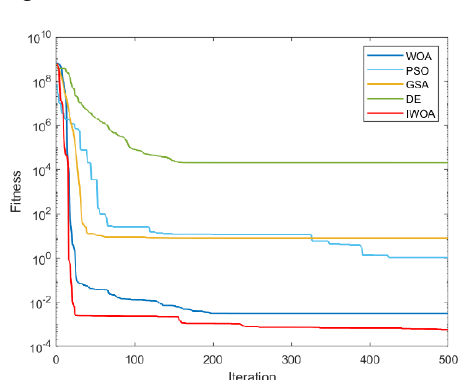
Figure 12. F7. Figure 12. F7.